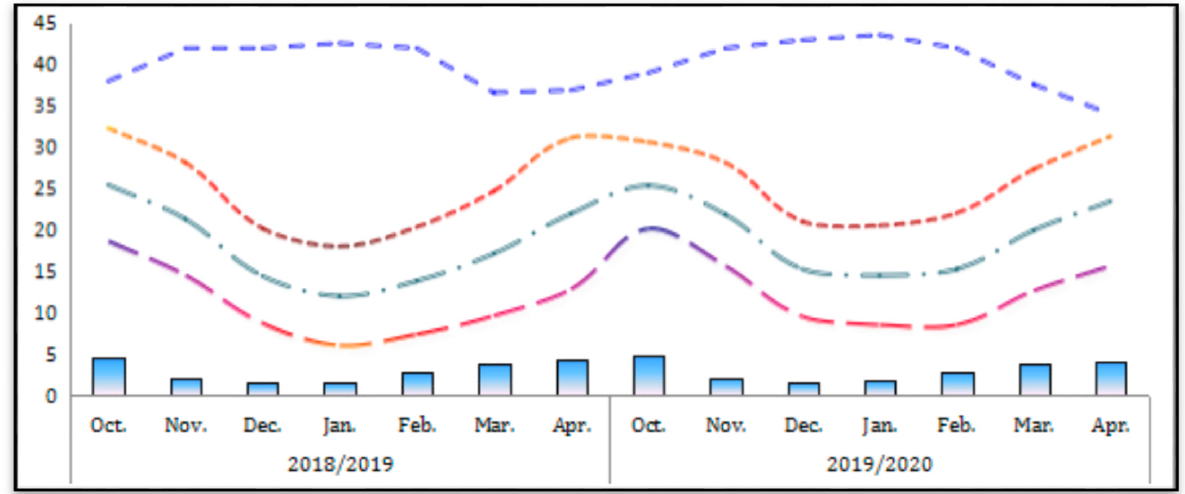
Figure 1. Monthly meteorological parameters in Fayoum Governorate from October to April during the 2018/2019 and 2019/2020 seasons. The experiments were conducted in a complete randomized design using a split-plot arrangement with three replications. Irrigation treatments were applied at three levels, including full watering (dI-00, control), deficit irrigation at 20% of crop evapotranspiration (ETc) (dI-20), and watering reduction at 40% of ETc (dI-40). The three irrigation treatments were imposed on the main plots of the experimental soil. For each of the three irrigation treatments, phosphorus (P) was applied for three treatments, namely conventional phos- phorus (cP), phosphorus nanoparticles of 50 nm (nP-1), and phosphorus nanoparticles of 25 nm (nP-2). The three fertilization treatments were imposed on the subplots of the experimental soil. Both the irrigation and fertilization treatments consisted of nine com- bination treatments with three replications each, giving a total of 27 plots. The area of each experimental plot was 6 m 2 (2.5 m × 2.4 m) with four rows of 2.5 m in length and 60 cm apart. Fertilization with cP was applied to the plots before sowing at 400 kg P 2 O 5 ha − 1 (0.24 kg plot − 1 ) sourced from calcium superphosphate (15.5% P 2 O 5 ). Using the foliar spray technique, nP-1 and nP-2 were sprayed twice on days 30 and 60 from sowing. Each nP (prepared from calcium phosphate, 18% P and 6% Ca) was sprayed at a concentration of 0.1 g L − 1 using a 20 L dorsal Sprayer (model 0417.02.00; Guarany Ind. & Com. Ltd.,